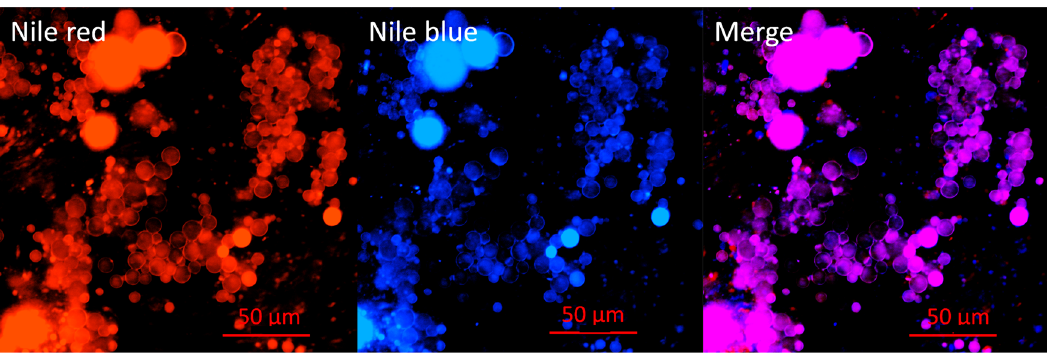
Figure 4: Fluorescent micrographs of O/W Pickering emulsion stabilized by CNC – SPI nanoconjugates with double staining. The scale bar corresponds to 50 μ